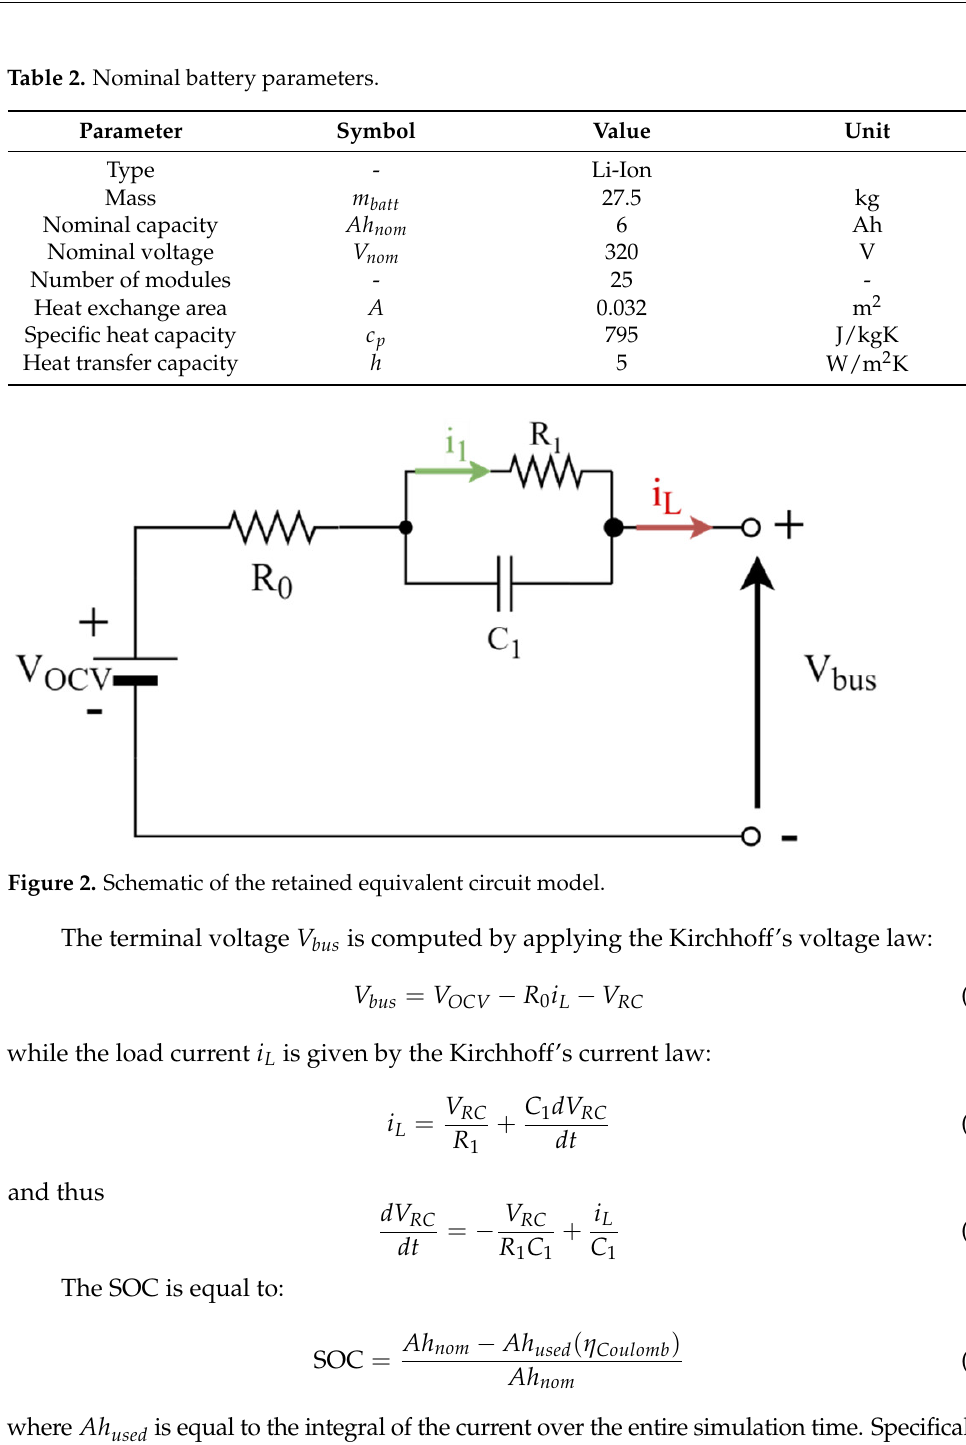
Table 2. Nominal battery parameters.